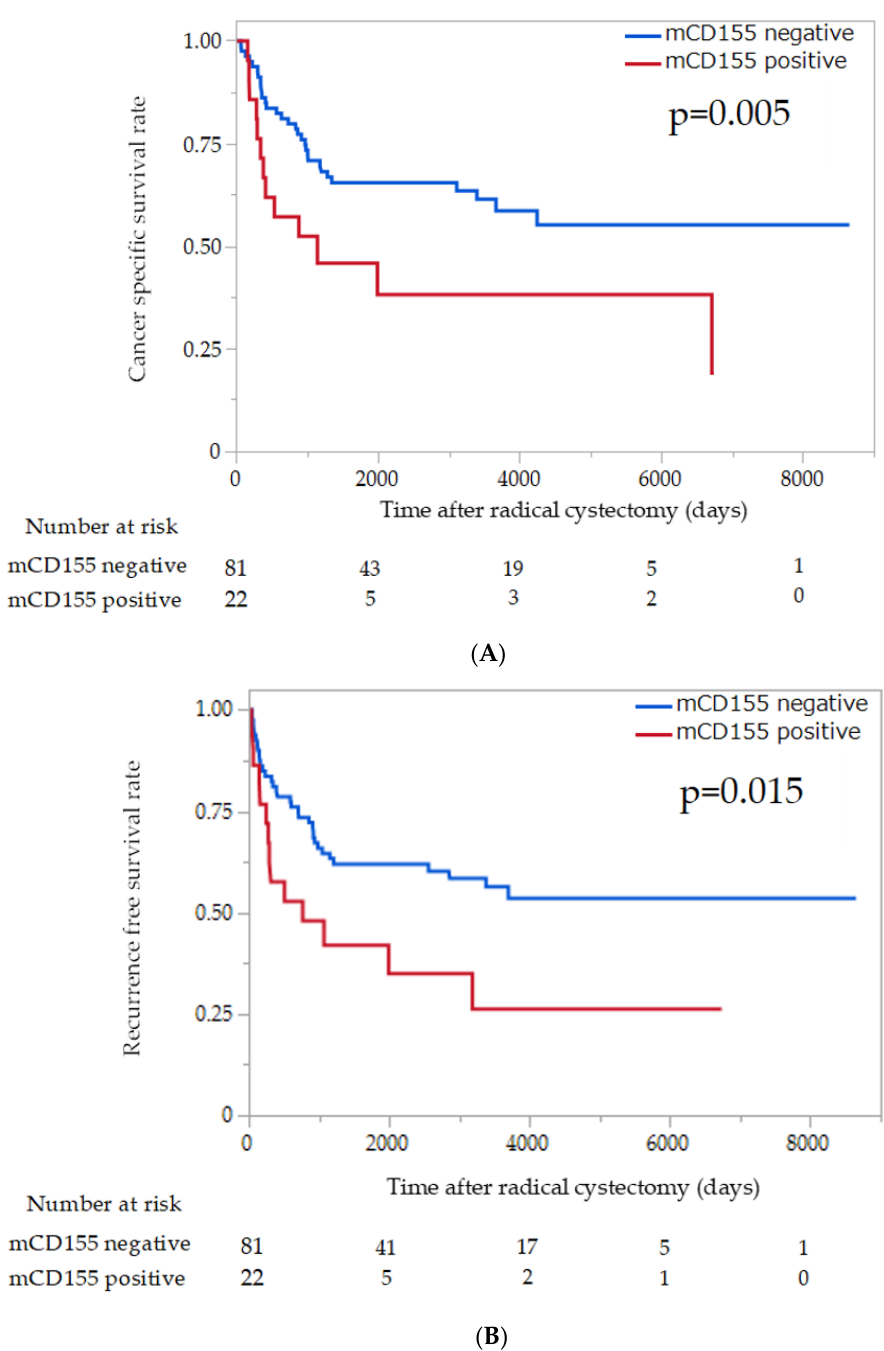
Figure 2. Probability of survival in patients with urothelial carcinoma of the bladder according to mCD155 expression estimated using the Kaplan–Meier method. ( A ) Cancer-specific survival; ( B ) recurrence-free survival. Table 2. Univariate and multivariate Cox proportional hazards analyses to predict cancer-specific survival and recurrence free survival in patients with bladder cancer treated with radical cystec- tomy.